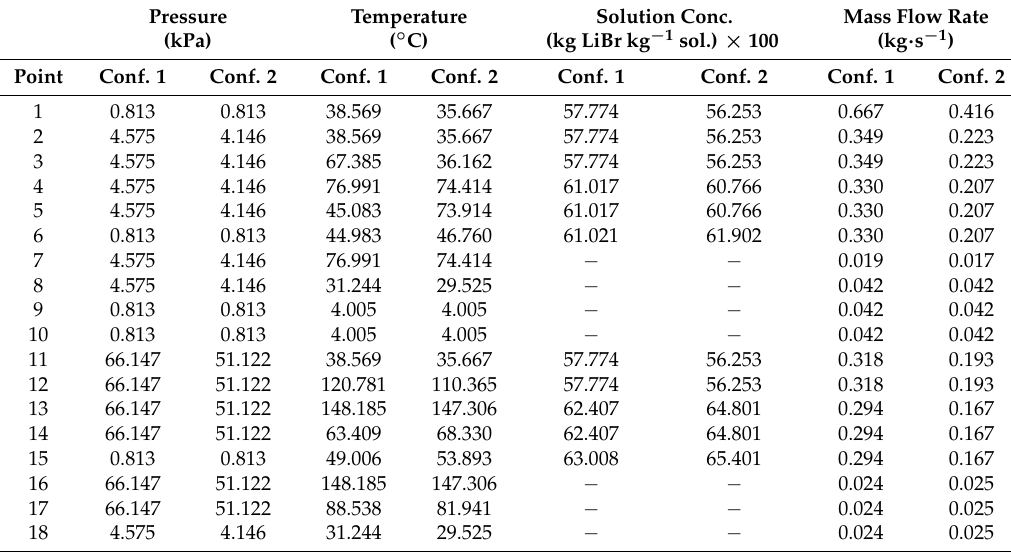
Table 6. Optimal values of operating conditions obtained for configurations Conf. 1 and Conf. 2 for a cooling capacity of 100